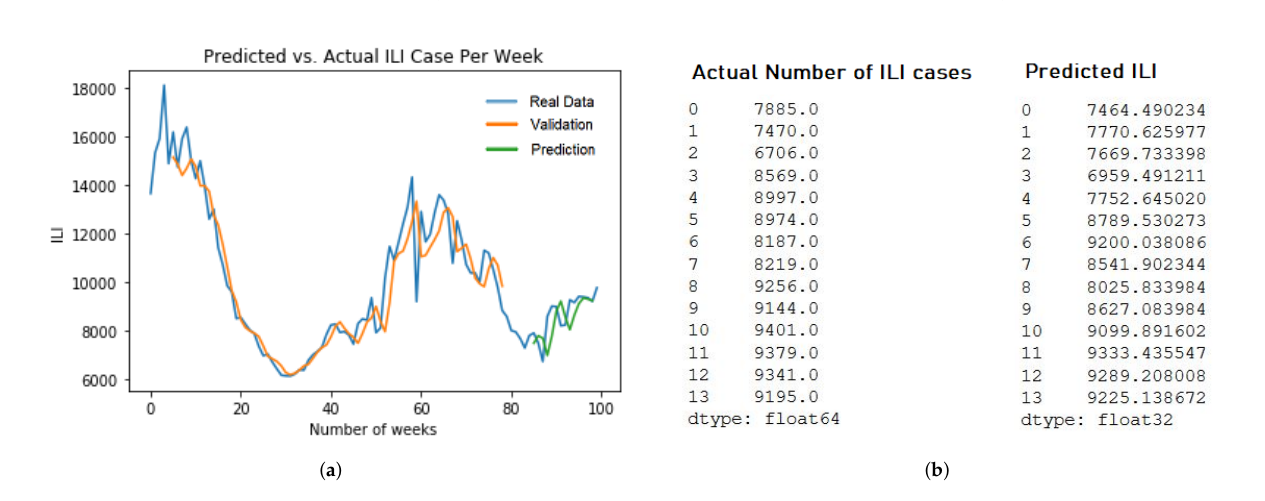
Figure 9. ILI LSTM sampling predictions. ( a ) ILI LSTM MC model for 10 years dataset training;